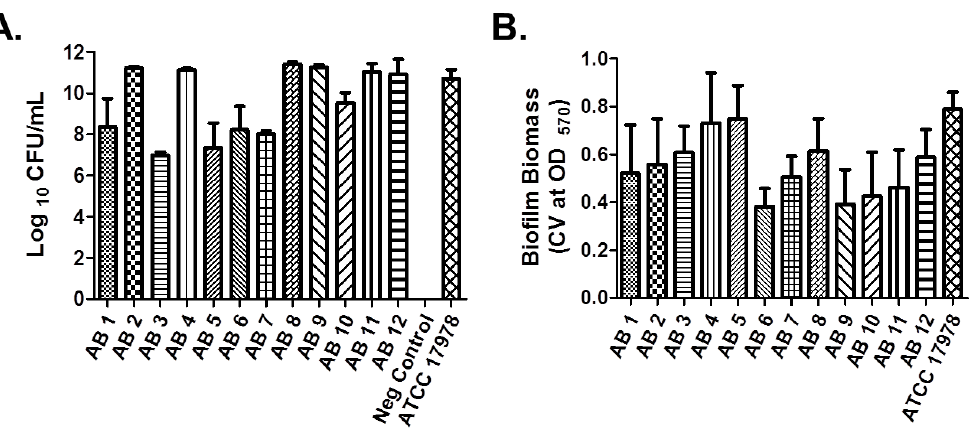
Figure A2. Screening of biofilm formation amongst clinical isolates of A. baumannii used in this study. ( A ) A. baumannii isolates were grown in MHB II broth at 37 °C and then incubated in the MBEC device overnight as previously described in the methods used in 4.5. Results shown are colony counts recovered from individual pegs after sonication of biofilms on MBEC plates and expressed as Log 10 ; ( B ) screening of biofilm formation amongst the clinical isolates assessed by quantitating biofilm biomass by measuring the absorbance of ethanol solubilized crystal violet at 570 nm (CV at OD 570 ) of previously stained biofilms. Bars represent the mean ± SEM of three independent experiments.